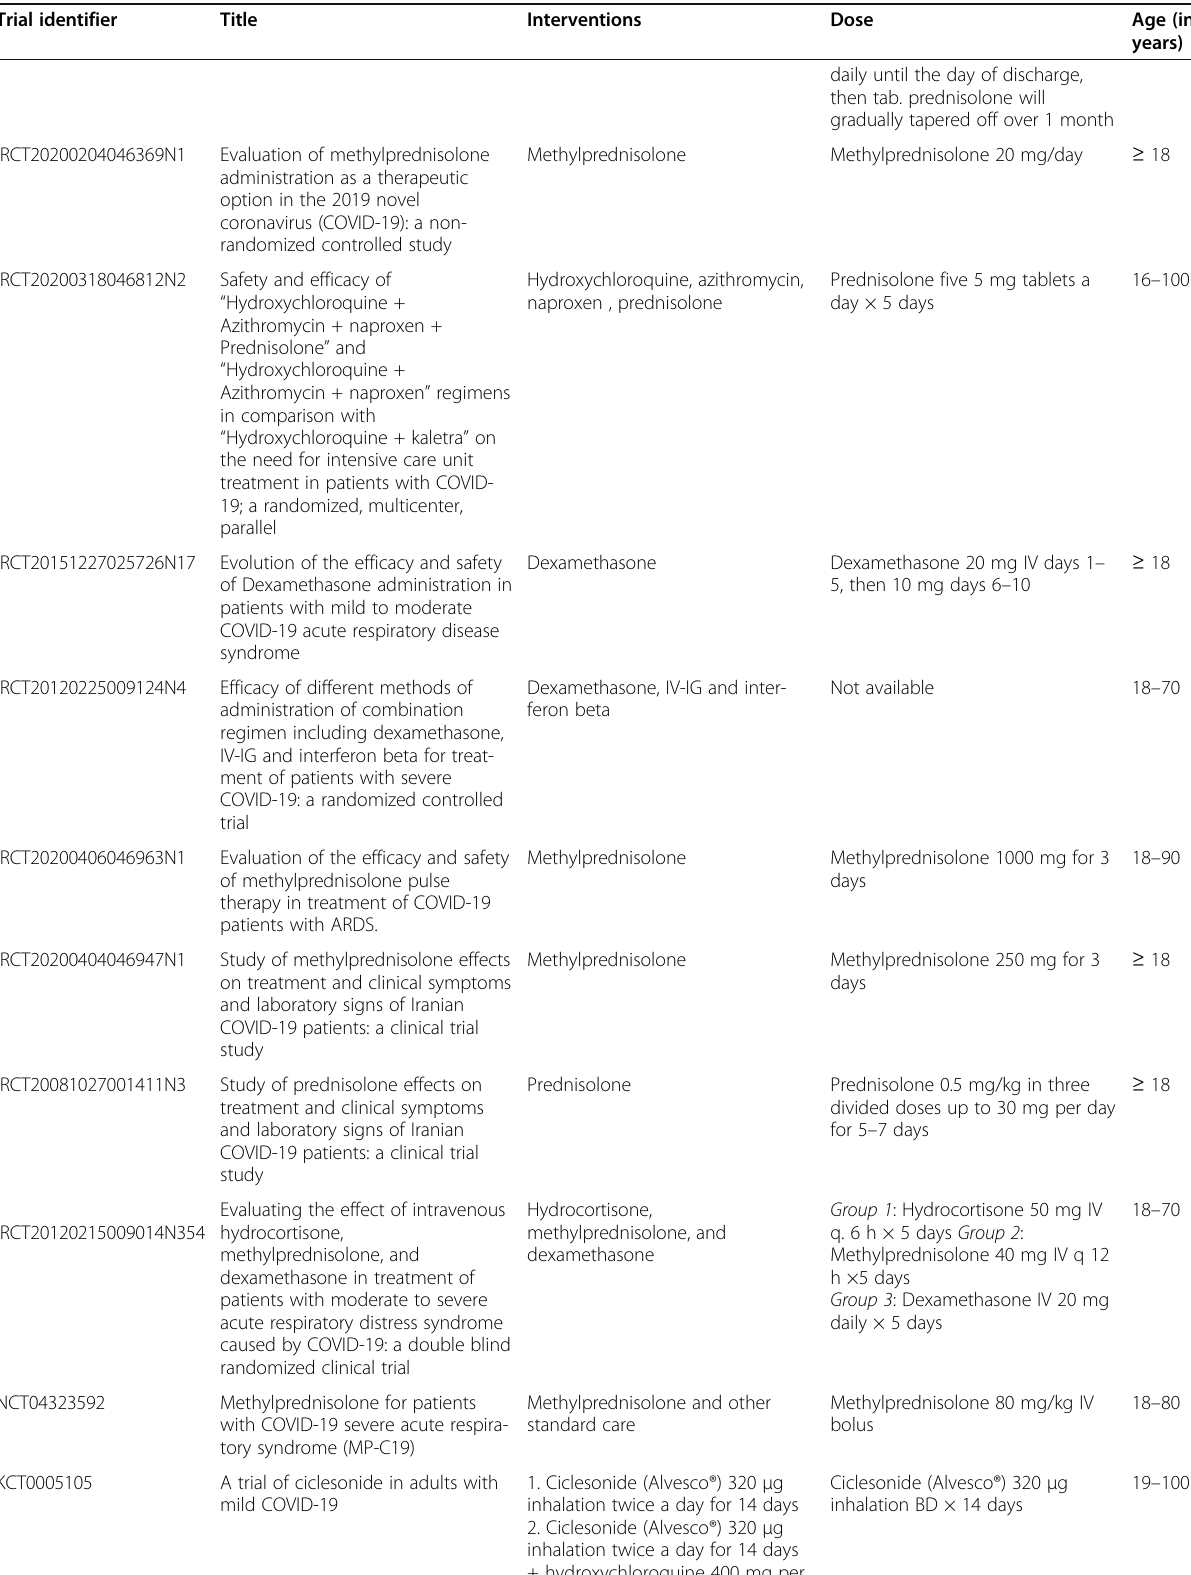
Table 3 Steroid treatment in patients with COVID-19 (Continued) Trial